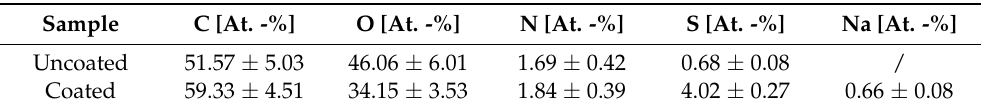
Table 1. EDX ‐ data of uncoated and PEDOT:PSS ‐ coated nonwoven material, showing an increase of atomic mass of sulfur.